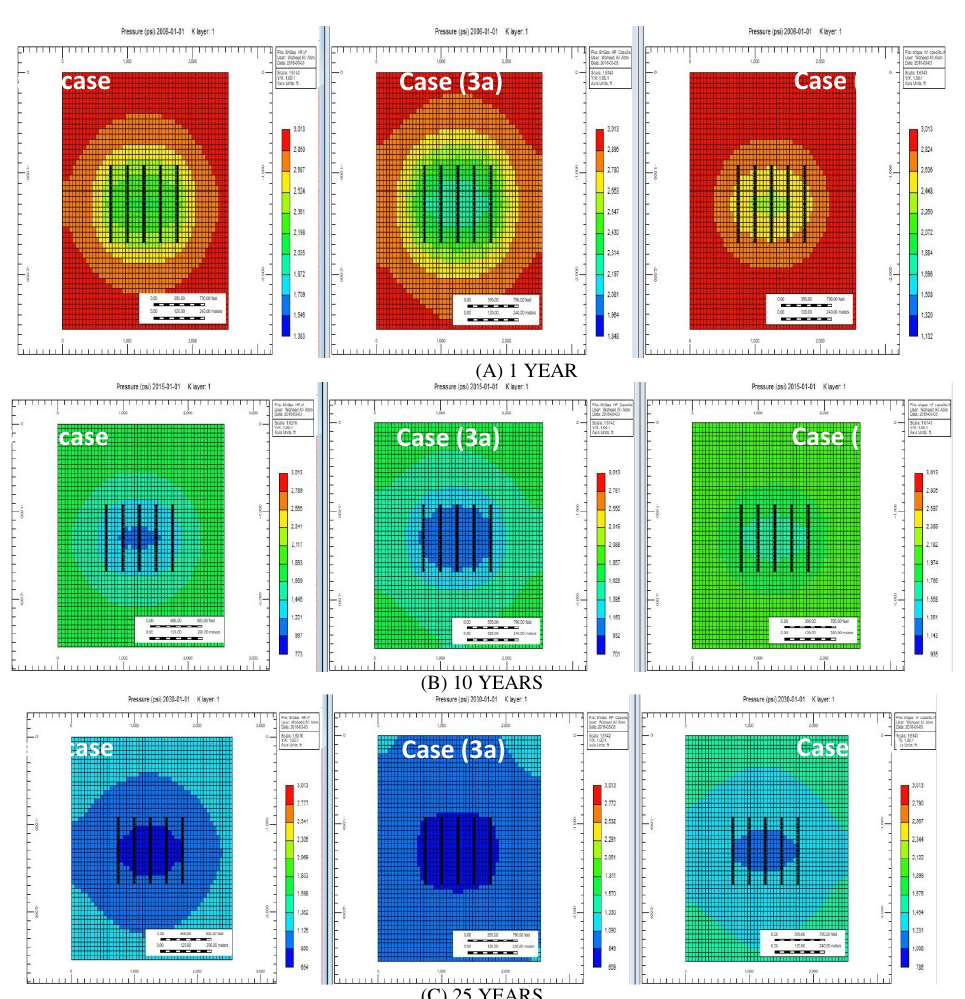
(C) 25 YEARS FIG. 7. COMPARISON OF PRESSURES AT DRAINAGE BOUNDARY AT DIFFERENT TIME